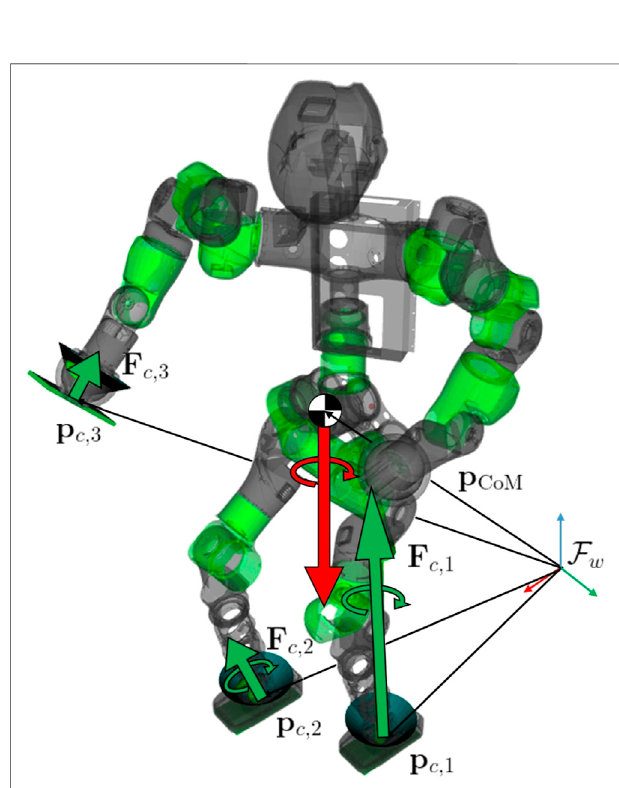
FIGURE 2 | Centroidal statics and robot con fi guration starting from planned contacts. The green arrows represent the contact forces and torques. These lasts are limited to the surface contacts only (feet). The friction cones are also shown for the three active contacts. The red arrows represent the weight force and the derivative of the angular momentum exerted directly on the CoM of the robot. Position vectors of each contact and CoM are highlighted w.r.t. the inertial frame F w